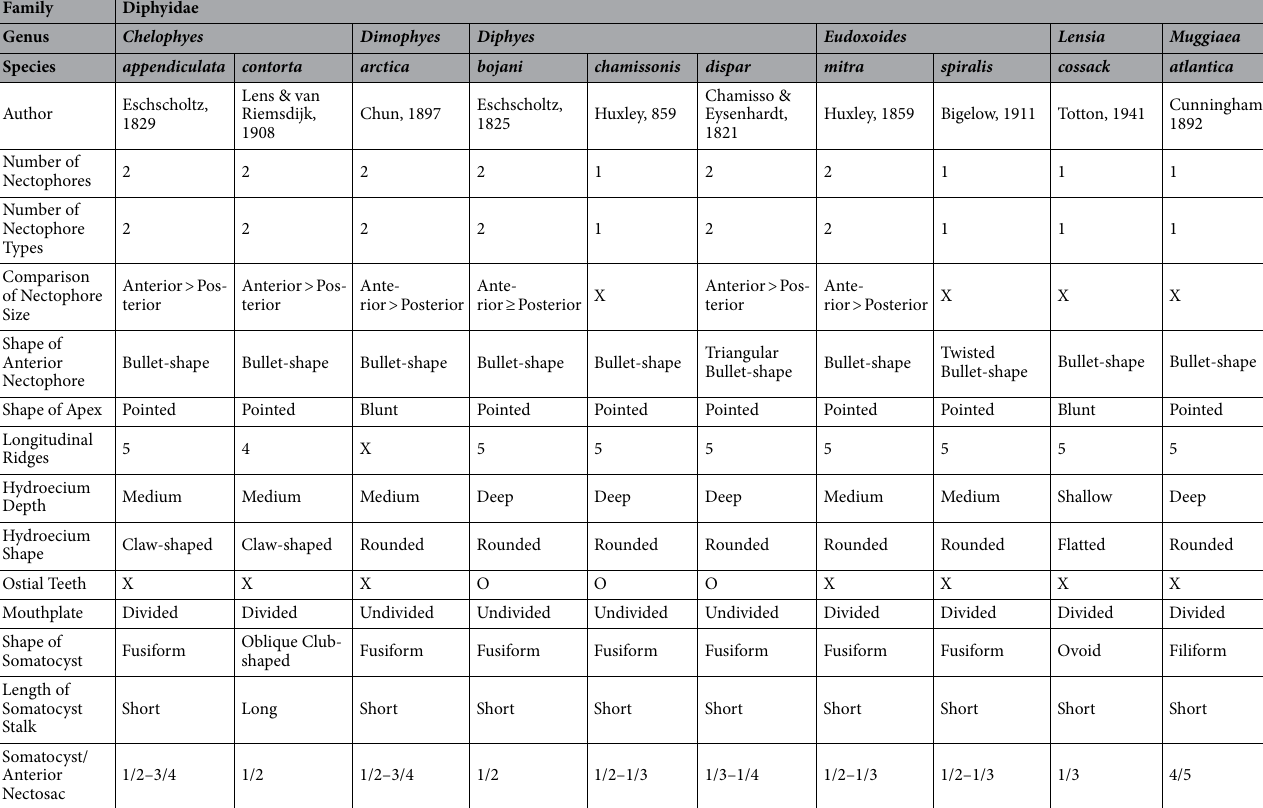
Table 1. Morphological comparisons between the ten Diphyidae species from ethanol-fixed samples. O: presence; X: absence.